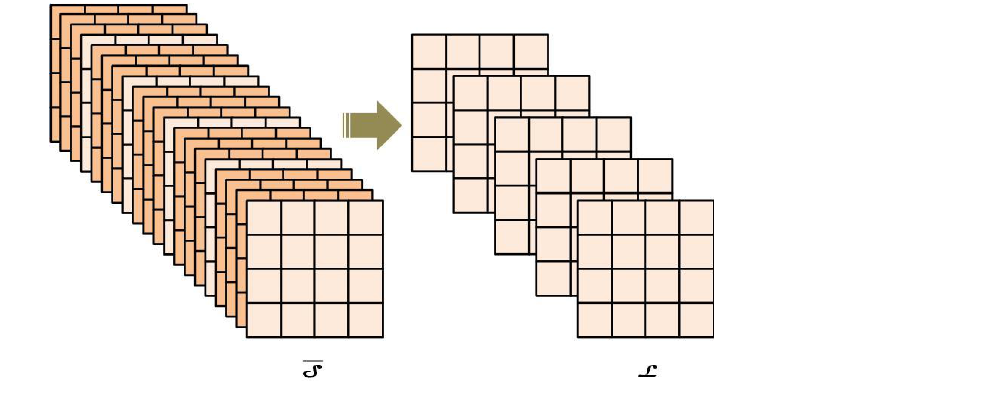
Figure 5. A schematization of the pre-processing strategy based on sub-sampling.